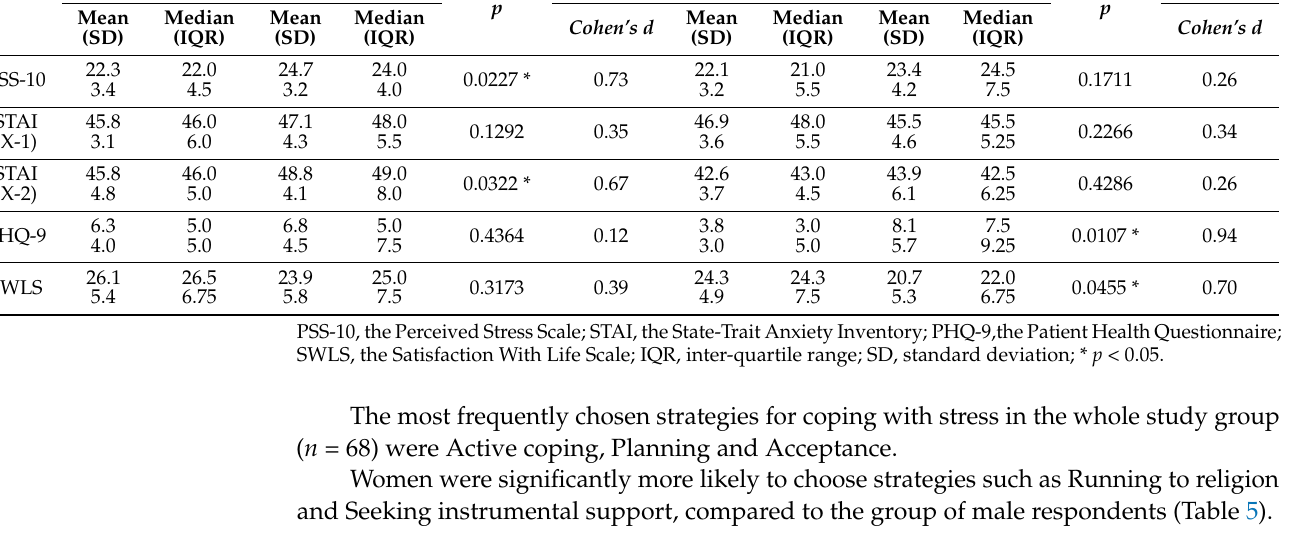
Table 5. Strategies for coping with stress according to sex (Mann–Whitney U